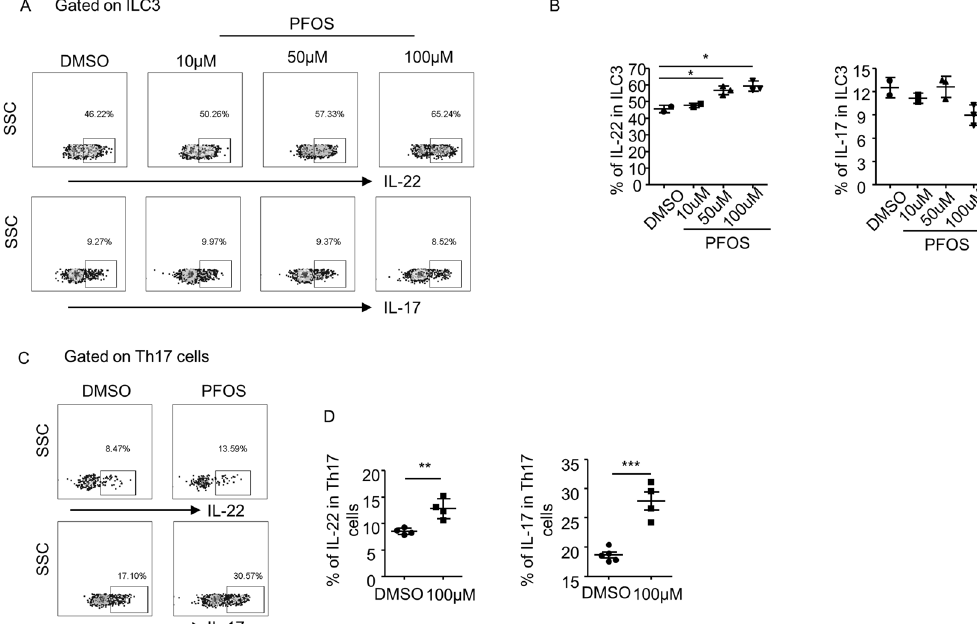
Figure 3. PFOS promotes cytokine production from intestinal ILC3 and Th17 cells in vitro . Large intestinal LPLs were isolated from wild-type mice and treated with indicated concentrations of PFOS or DMSO for 20 hr. Cells were stimulated with PMA and ionomycin for the last 4 h before harvested for flow cytometry analysis. ( A and C ) The expression of CD3, CD4, ROR γ t, IL-17 and IL-22 from indicated samples was analyzed by flow cytometry. ( B ) Percentages of IL-22 and IL-17 expression gated on ILC3 (CD3 − ROR γ t + cells) were shown. ( D ) Percentages of IL-22 and IL-17 expression gated on Th17 (CD3 + CD4 + ROR γ t + ) cells were shown. Horizontal lines show the mean. Error bars represent SEM. Data are representative of two independent